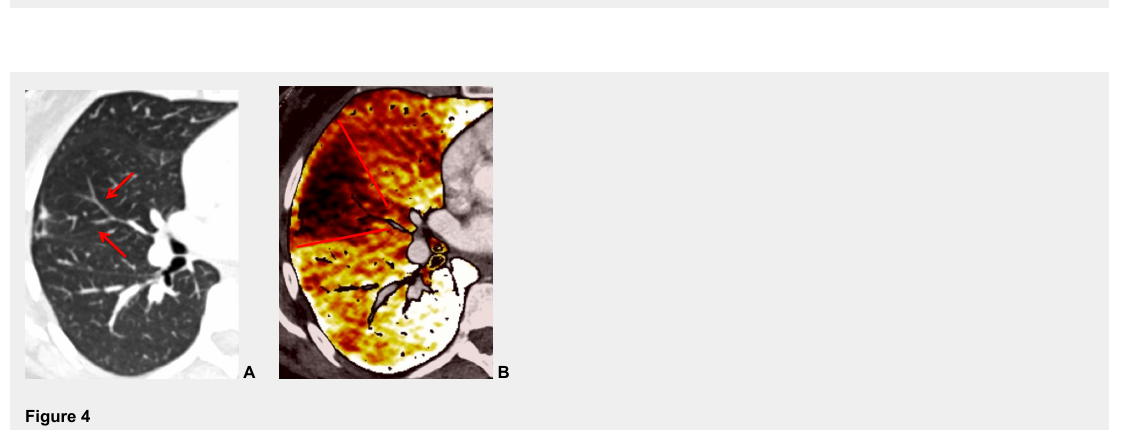
Figure 3 Chronic thromboembolic pulmonary hypertension (CTEPH). Segmental occlusions of pulmonary arteries (arrow) in the pulmonary angiography ( A ) are clearly visible on the CT angiography ( B ), with normal lung ( C ), and responsible for triangular perfusion defects (arrows) on the perfusion maps ( D ) confirmed by the ventilation-perfusion scintigraphy ( E–F ).